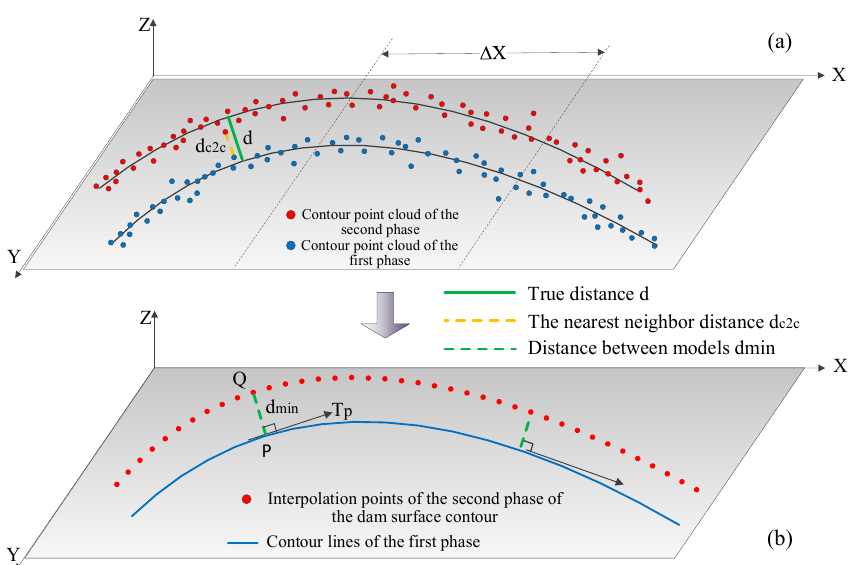
Figure 3. Local curve fitting and model distance comparison. ( a ) Piecewise curve fitting and ( b ) model-to-model distance comparison.